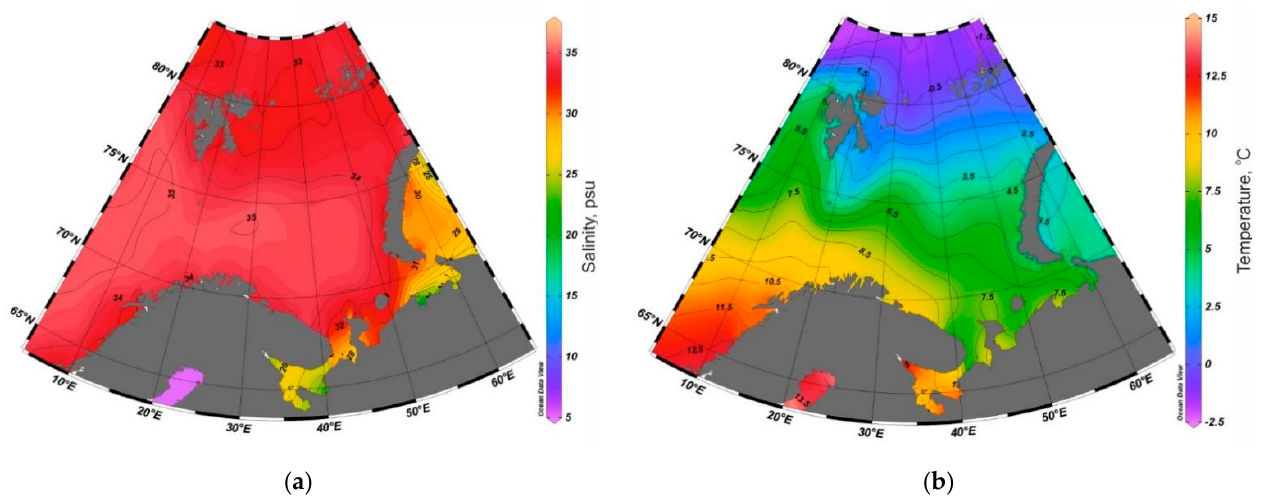
Figure 2 . Map of mean summer ( a ) sea surface salinity and ( b ) temperature in the White and Barents Seas between 1955 and 2012, after the World Ocean Atlas [50,51].